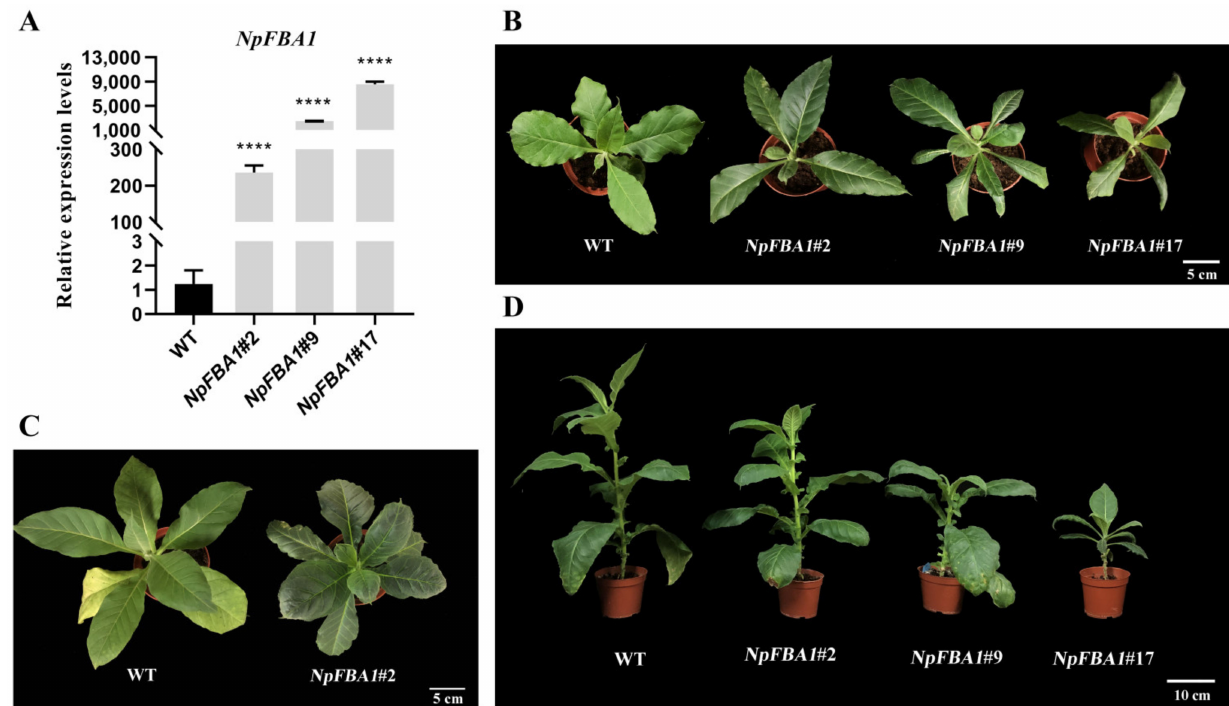
Figure 4. Expression analysis of NpFBA1 and its effect on plant growth and development. ( A ) Expression levels of NpFBA1 in both WT and transgenic plants, Asterisks indicate significant differences between WT and transgenic plants, **** p < 0.0001, by Student’s t -test, number of samples, n = 23. ( B , C ) Leaf development of at the rosette stage in WT and transgenic plants. ( D ) Stem length status of WT and transgenic plants.